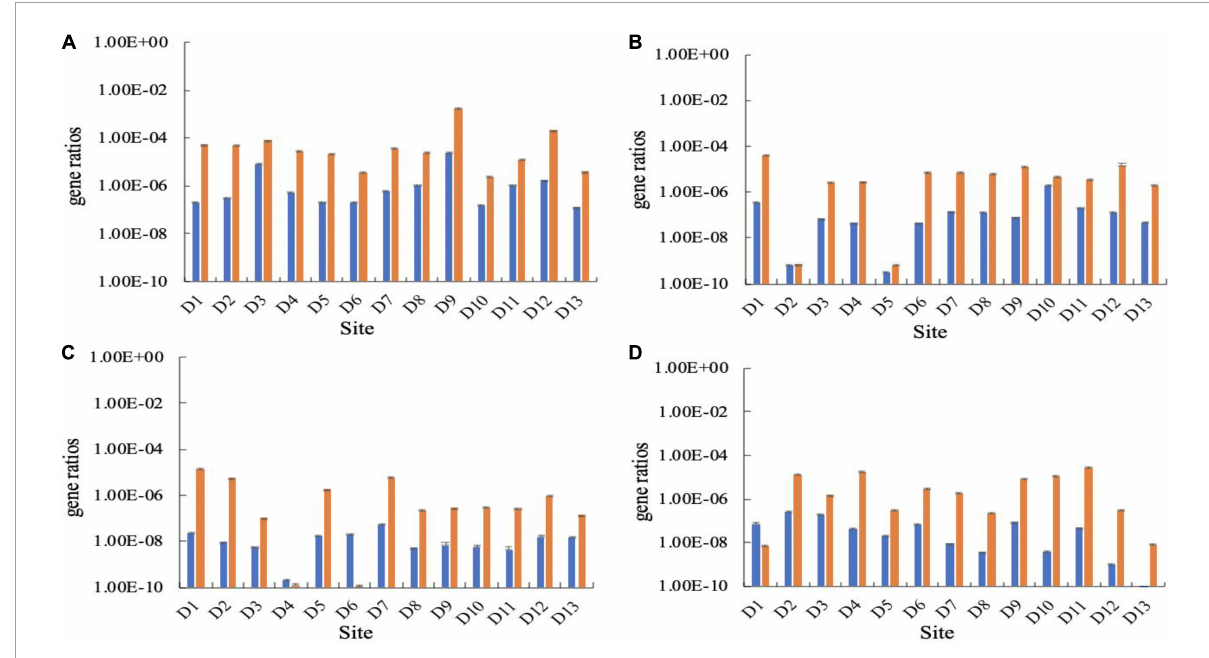
FIGURE3 Ratios of gene copy numbers of cbbL (left, blue) or cbbM (right, orange) to 16S rRNA genes in the Huixian karst groundwaters. (A) Winter (201801); (B) Spring (201804); (C) Summer (201807); (D) Autumn